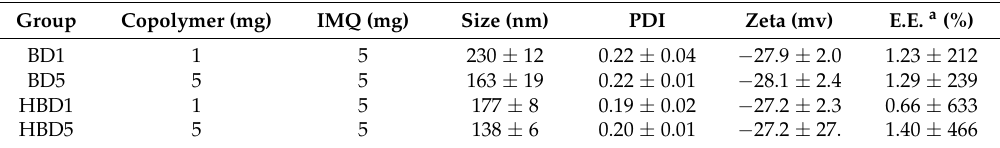
Table 2. Characteristic of HBD and BD polymeric nanoparticles with high and low copolymer/IMQ feed ratio.